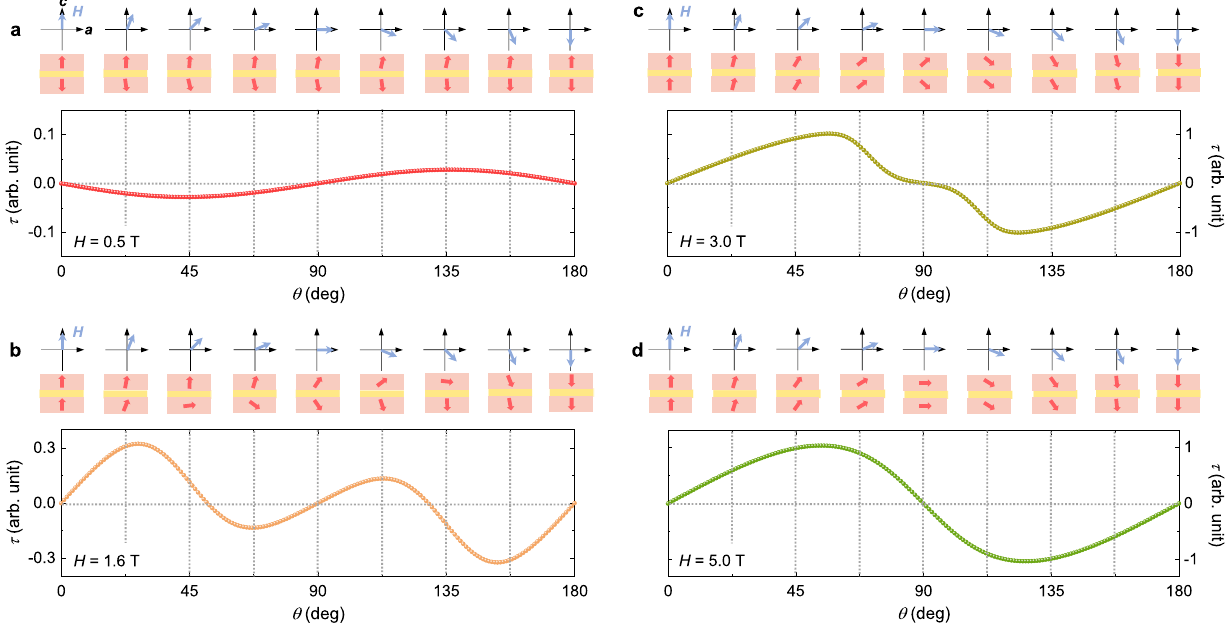
Figure 5. Detailed spin configurations for angle-dependent torques. ( a ) Angle dependence of magnetic τ , calculated by fitting to the experimental τ data at T = 2 K. H is rotated in the ac plane at H = 0.5 T. The schematics designate the configurations of the net magnetic moments with respect to the H directions. ( b–d ) Calculated angle-dependent τ and corresponding net-moment arrangements at H = 1.6, 3, and 5 T,